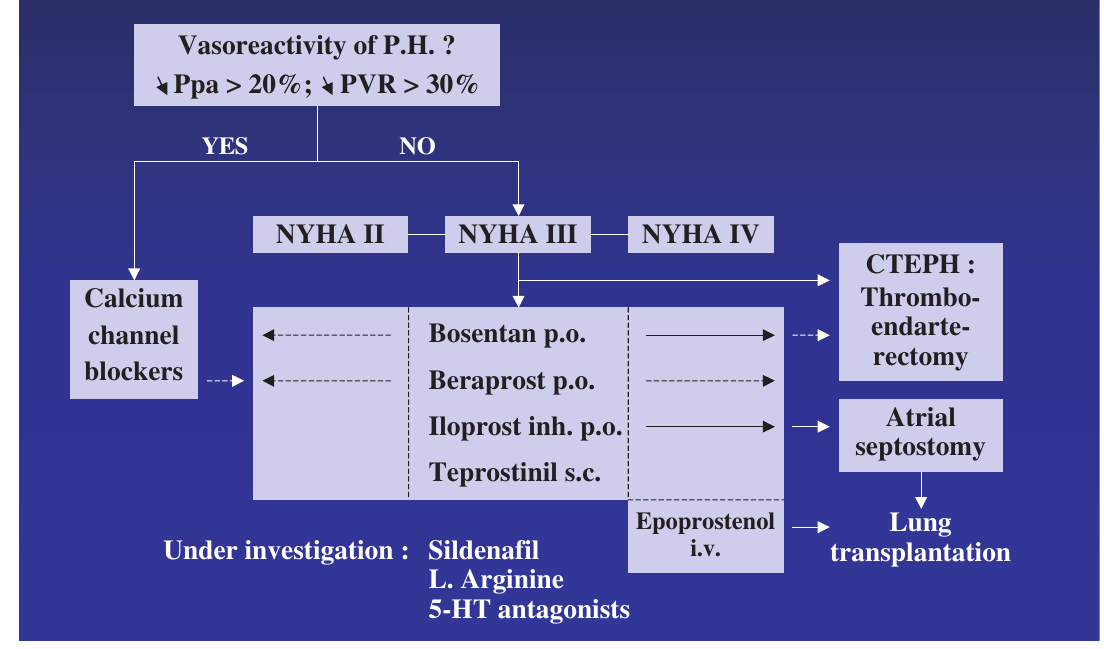
Treatment of pul- monary hyperten- sion. Abbreviations: PH: pulmonary